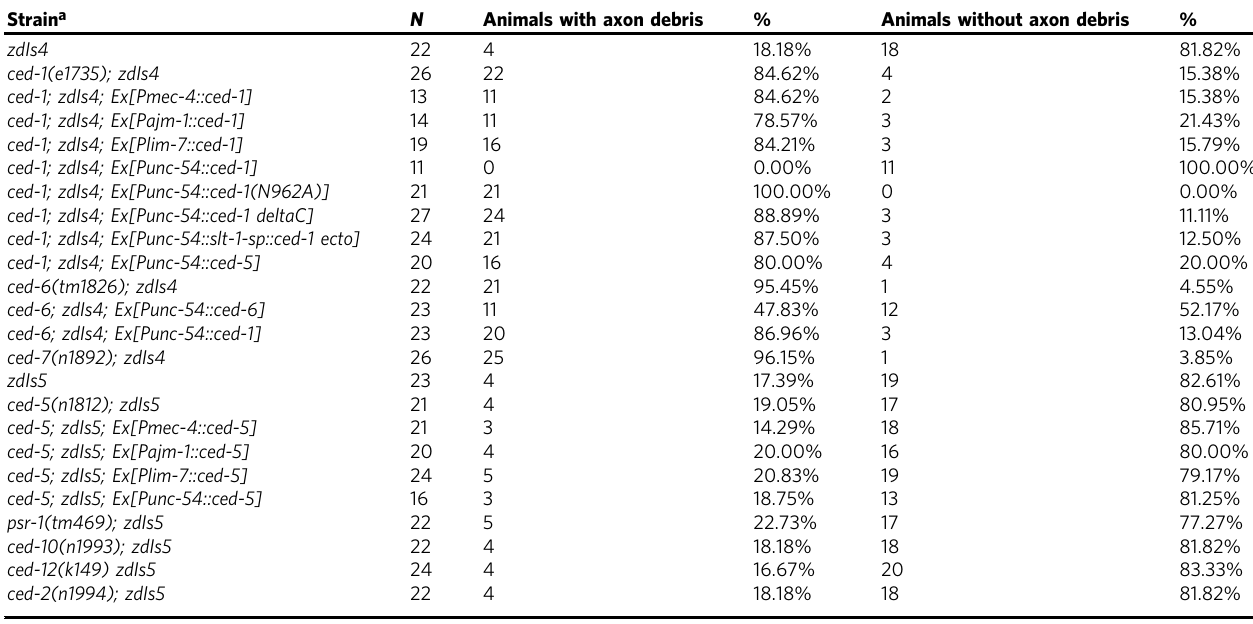
Table 1 Genetic determinants of axon debris clearance Strain a N Animals with axon